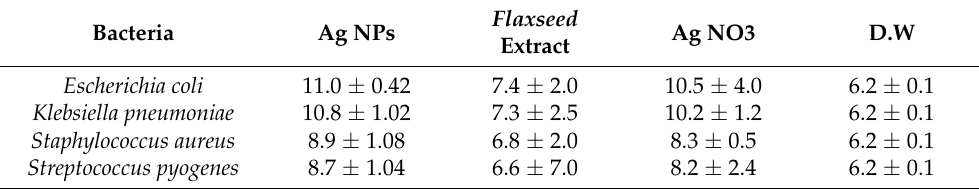
Table 2. Antimicrobial activity of flaxseed extract and green synthesized AgNPs.